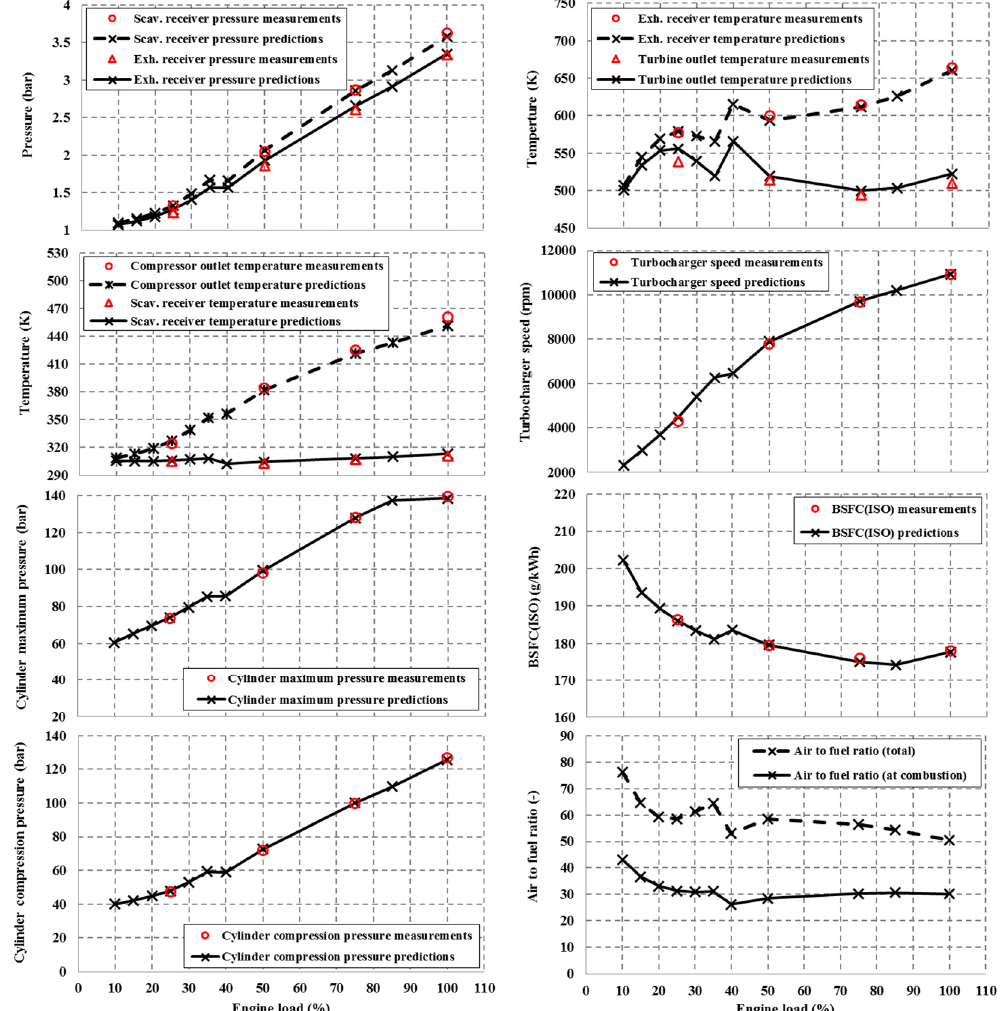
Figure 3. Steady state simulation results and comparison with shop trial data.